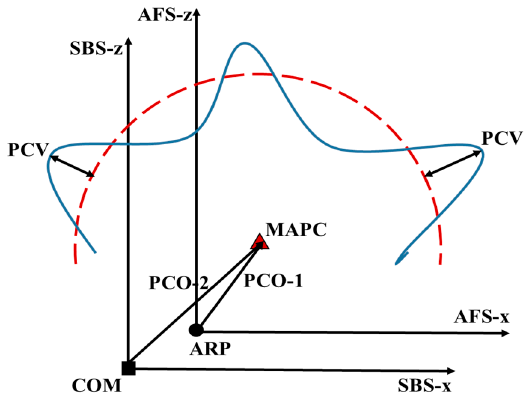
Figure 1. Antenna PCO and PCV model.